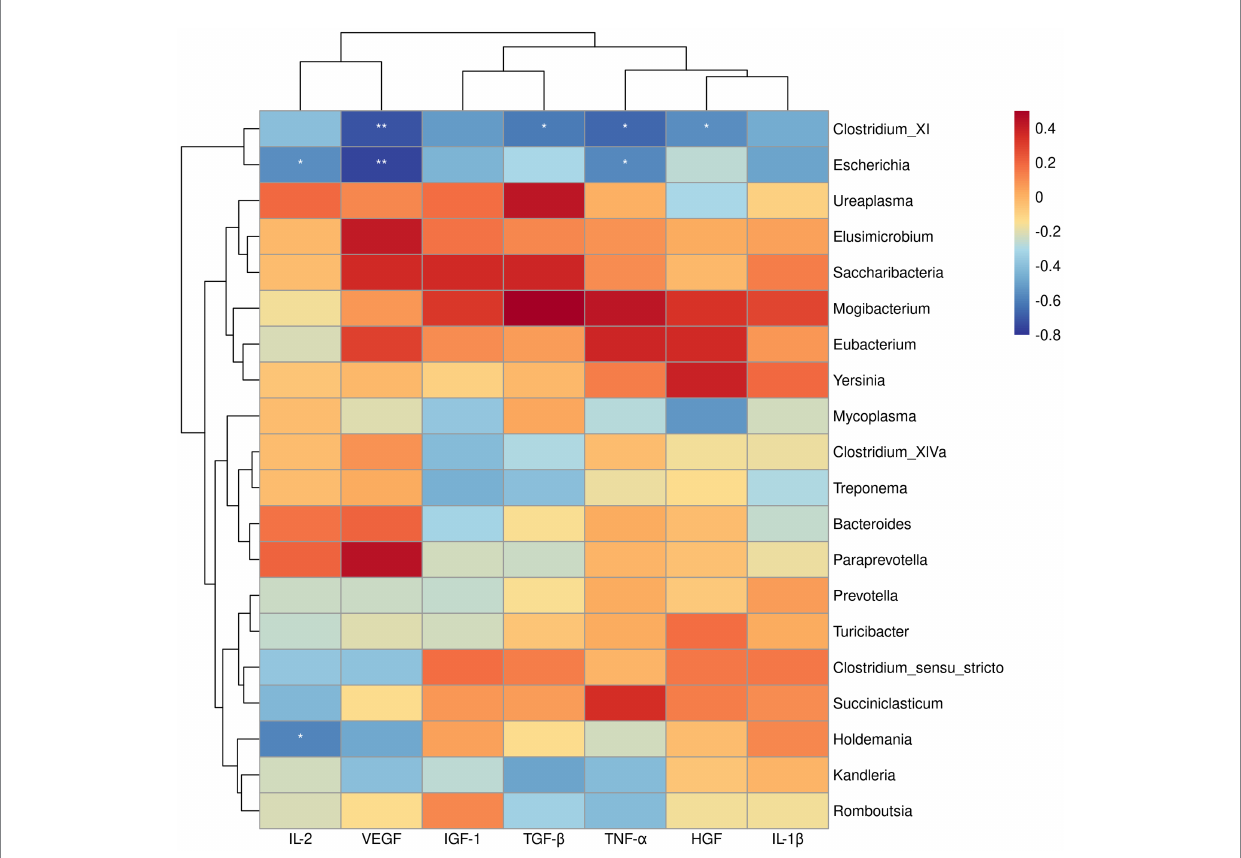
FIGURE 4 Heatmap of spearman’s correlation between serum cytokines and the relative abundance of top 20 bacteria at genus level in the ileum. The blue suggests a negative correlation, and the red suggests a positive correlation. * p < 0.05, ** p <